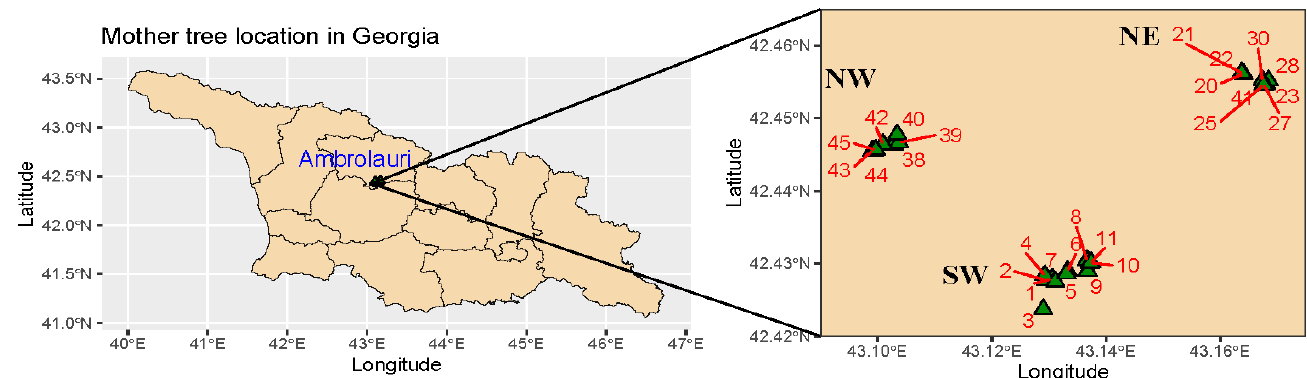
Figure 1. Geographical distribution of the 27 mother trees clustered into three areas (NE, NW, and SW) in the Ambrolauri region in Georgia, Caucasus. Each red number is the label of the 27 mother trees.